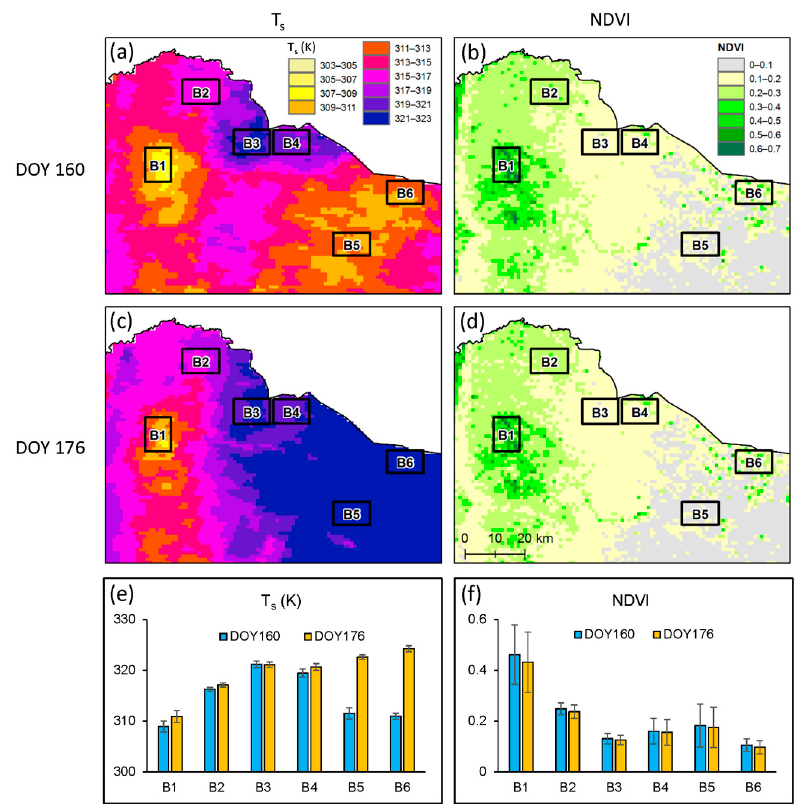
Figure 15. Comparison of NDVI and land surface temperature ( T s ) distributions on 9 June (DOY 160) and 25 June (DOY 176), 2009. ( a , b ) show the distributions of T s and NDVI for DOY 160, respectively. ( c , d ) show the distributions of T s and NDVI for DOY 176, respectively. ( e , f ) compare T s and NDVI, respectively, across six representative areas over both dates. The six areas are shown on the maps as black boxes B1–B6, representing forest area (B1), rainfed agricultural land (B2), and irrigated agricultural lands where T s variation is consistent with NDVI variation (B3 and B4) or inconsistent (B5 and B6). The stable NDVI values over DOY 160 and DOY 176 are consistent with the stable T s values in B1–B4, but they conflict with the T s changes observed in B5 and B6, which are likely caused by local weather events instead of evapotranspiration processes over the vegetated surface.